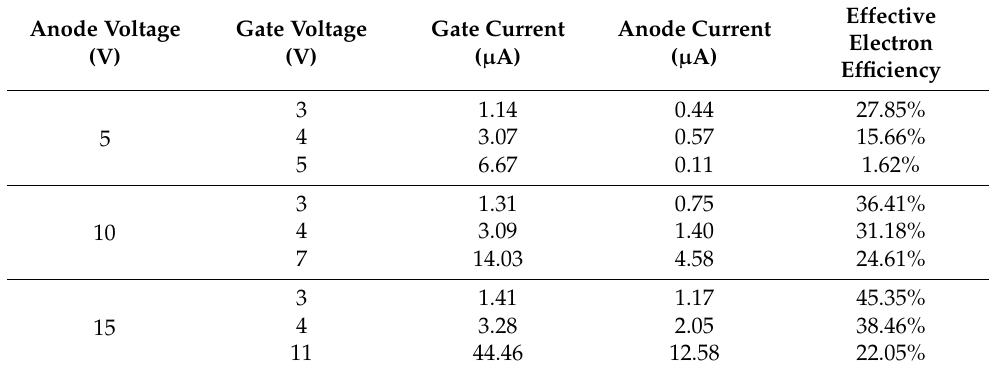
Figure 7. Electron trajectory at fixed anode voltage with different gate voltages: ( a ) 3 V and ( b ) 8 V. Table 2. Performance parameters of electron sources at different anode voltages and different gate